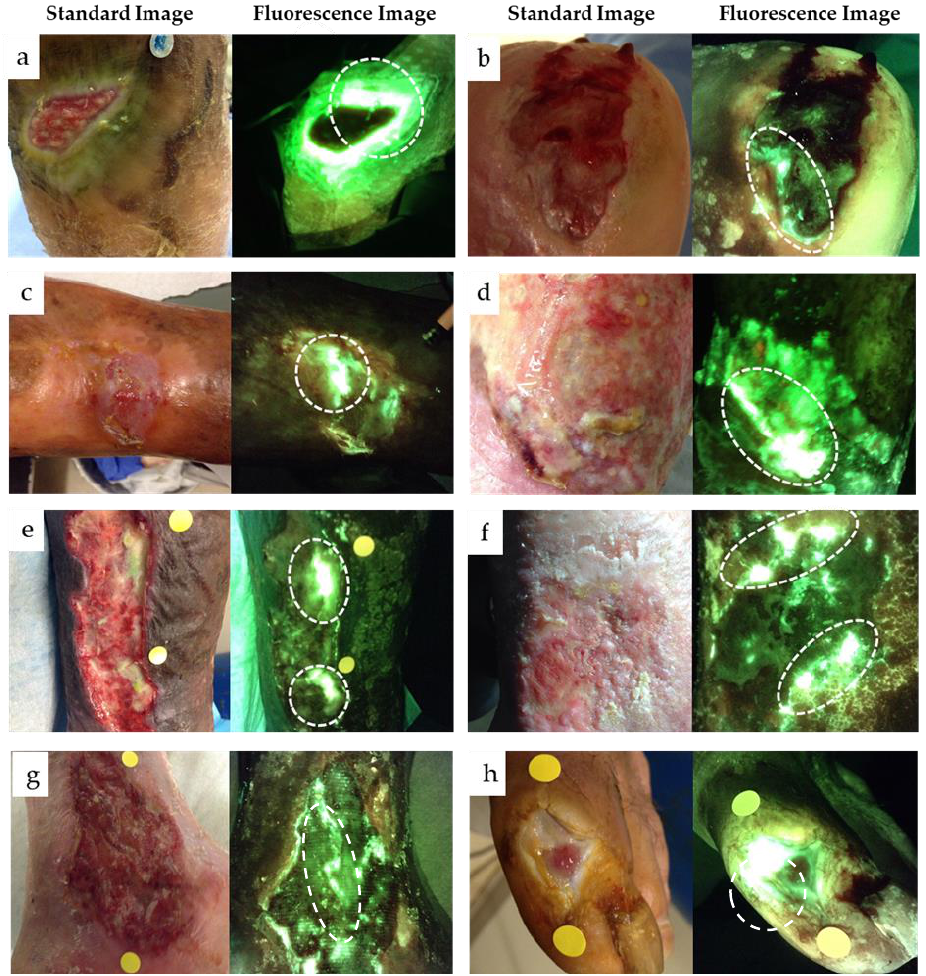
Figure 2. Example standard and fluorescence images of eight patients. Wound types included DFUs ( a , b , h ), VLUs ( c , d , f , g ) or other ( e ). Among the examples listed, only one wound ( a ) displayed the classic greenish tinge on bandages associated with presence of PA. Each wound had discrete locations of cyan fluorescence. A curettage sample was collected from the region(s) denoted by a dashed white circle in each wound image. Bacterial species and load were identified using semi-quantitative culture analysis. In all images shown here, regions of cyan fluorescence corresponded with presence of PA. Tissue appears green on fluorescence images.